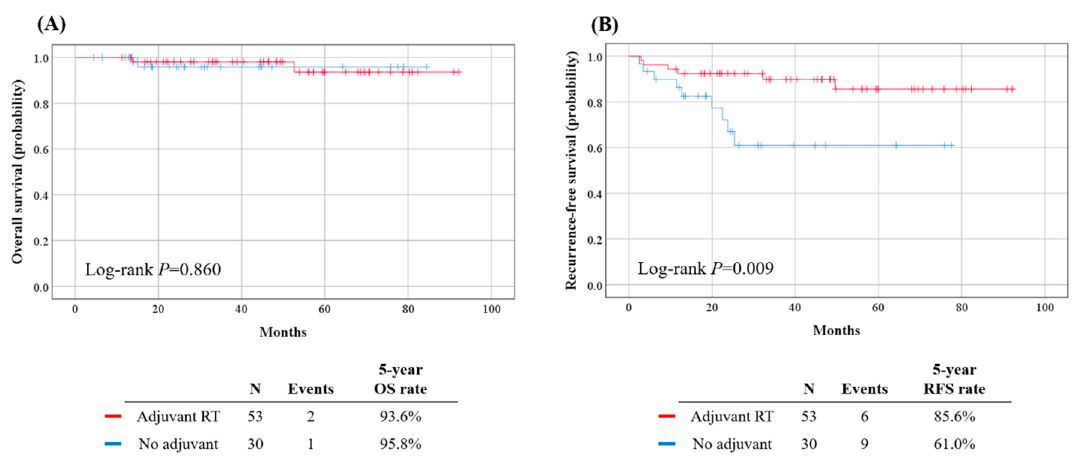
Figure 2. Comparisons of survival outcomes between the study and control groups. ( A ) Overall survival; ( B ) Recurrence-free survival. Table 2. Factors associated with recurrence-free